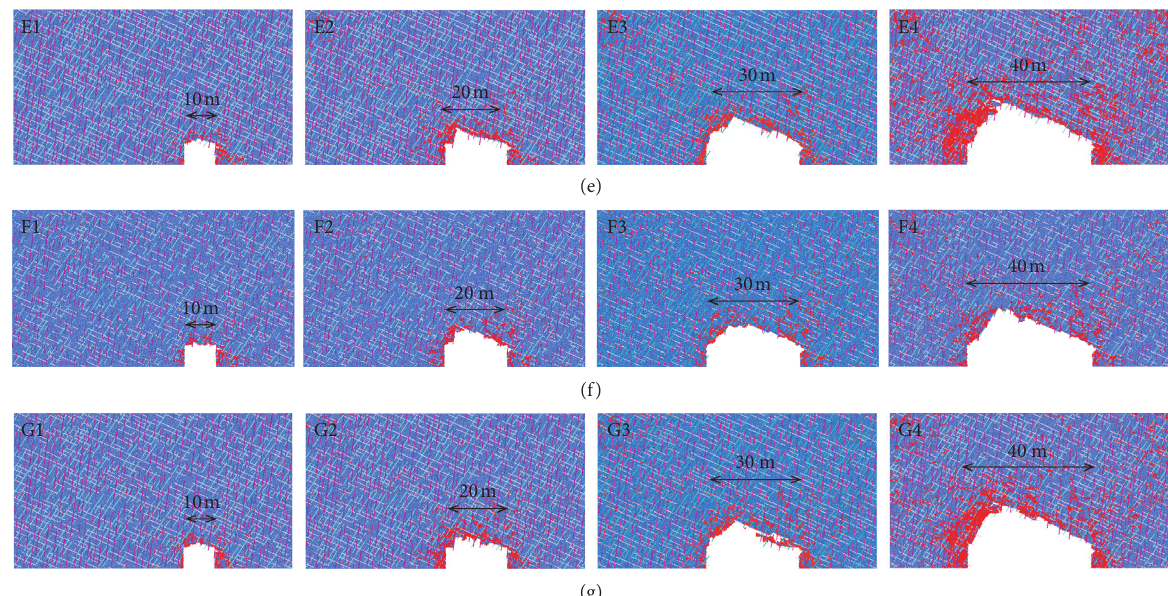
Figure 6: Crack propagation of the seven models. (a) No joints. (b) 24 ° joint set. (c) 124 ° joint set. (d) 98 ° joint set. (e) Joint system 1. (f) Joint system 2. (g) Joint system